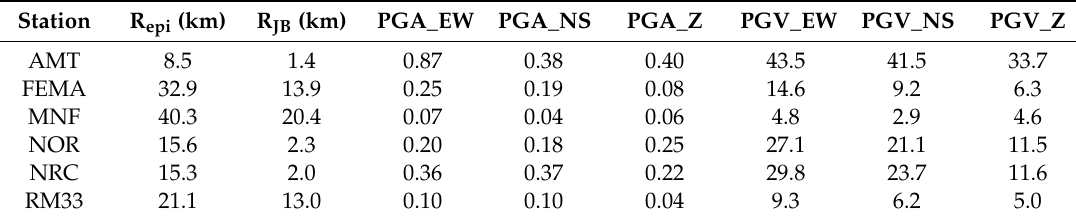
Table 2. Ground motion parameters peak ground acceleration (PGA) ad peck ground velocity (PGV) of 24 August 2016 records for the di ff erent seismic stations which recorded the earthquake ground motion. Accelerations and velocities are expressed in g and cm / s, respectively. PGA = Peak Ground Acceleration; PGV = Peak Ground Velocity.